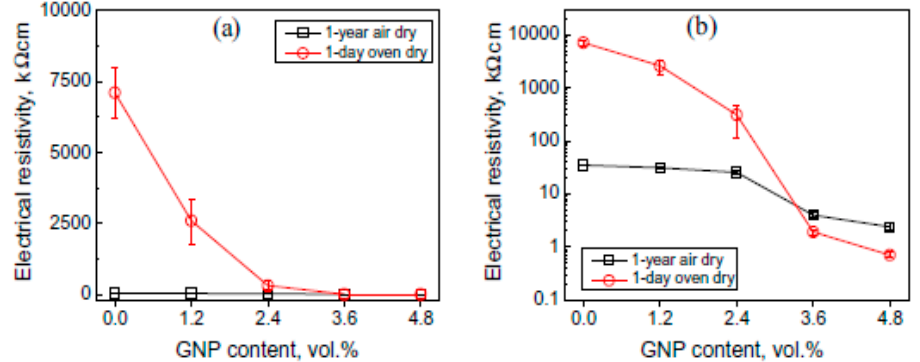
Figure 27. The relation between the electrical resistivity of the GNPs cement mortar composite and its respective GNPs content in ( a ) linear scale and ( b ) log scale. Reproduced with permission from [174], Elsevier, 2014.